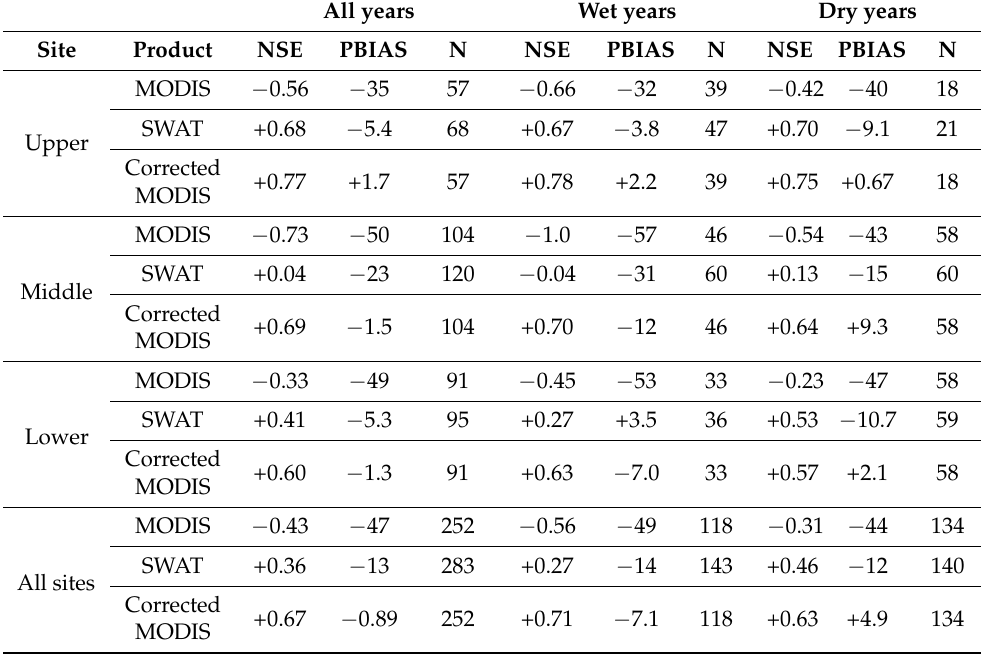
Table 2. Error statistics of monthly ET from MODIS, SWAT, and air temperature corrected MODIS, relative to flux tower observations. “All site” statistics (bottom) are for monthly ET data concatenated across the three sites. “All years” are water years 2009–2018, “wet years” are water years 2009– 2011 and 2016–2017, and “dry years” are water years 2012–2015 and 2018. NSE =